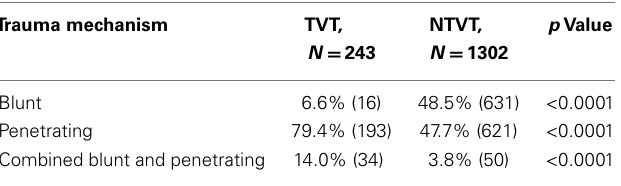
Table 3 |Vascular trauma – mechanism of injury –TVT vs. NTVT groups (%, number) .